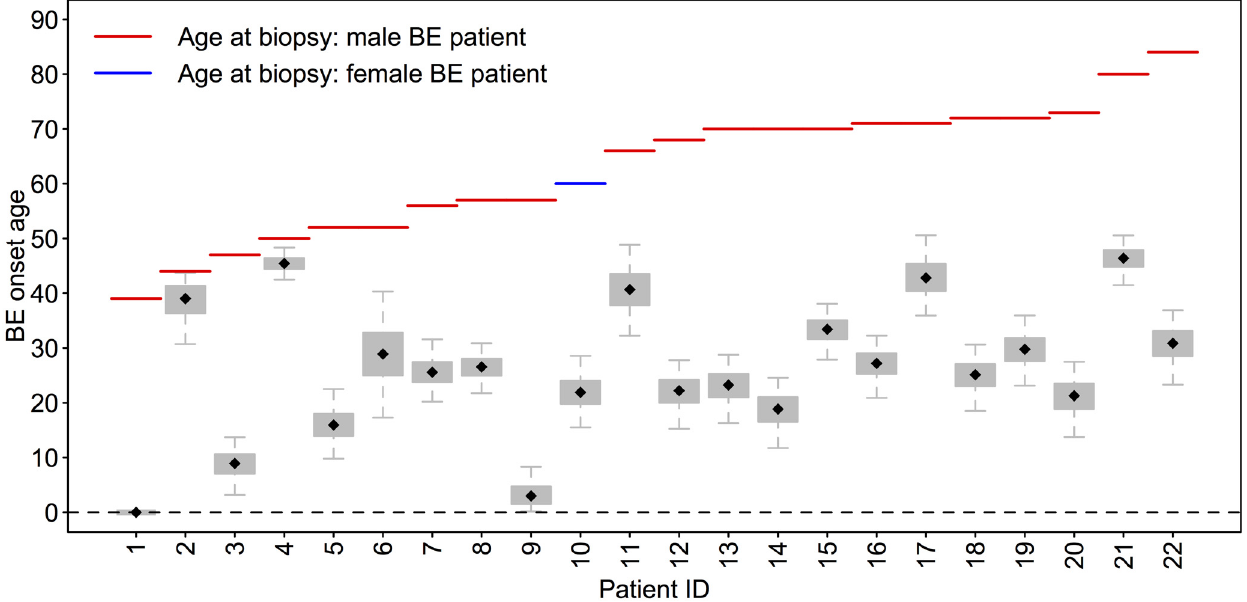
Fig 7. Predicted BE onset times for familial BE patients in D3. Boxplots depict the MCMC simulated posterior BE onset time distributions for all 22 patients, s i , i = 1, ... , 22, in data set D3. Testing via the Bayes factor suggests that the difference between average BE dwell times for FBE patients versus average BE dwell times for BE patients in data set D2 (see Fig 6) is highly